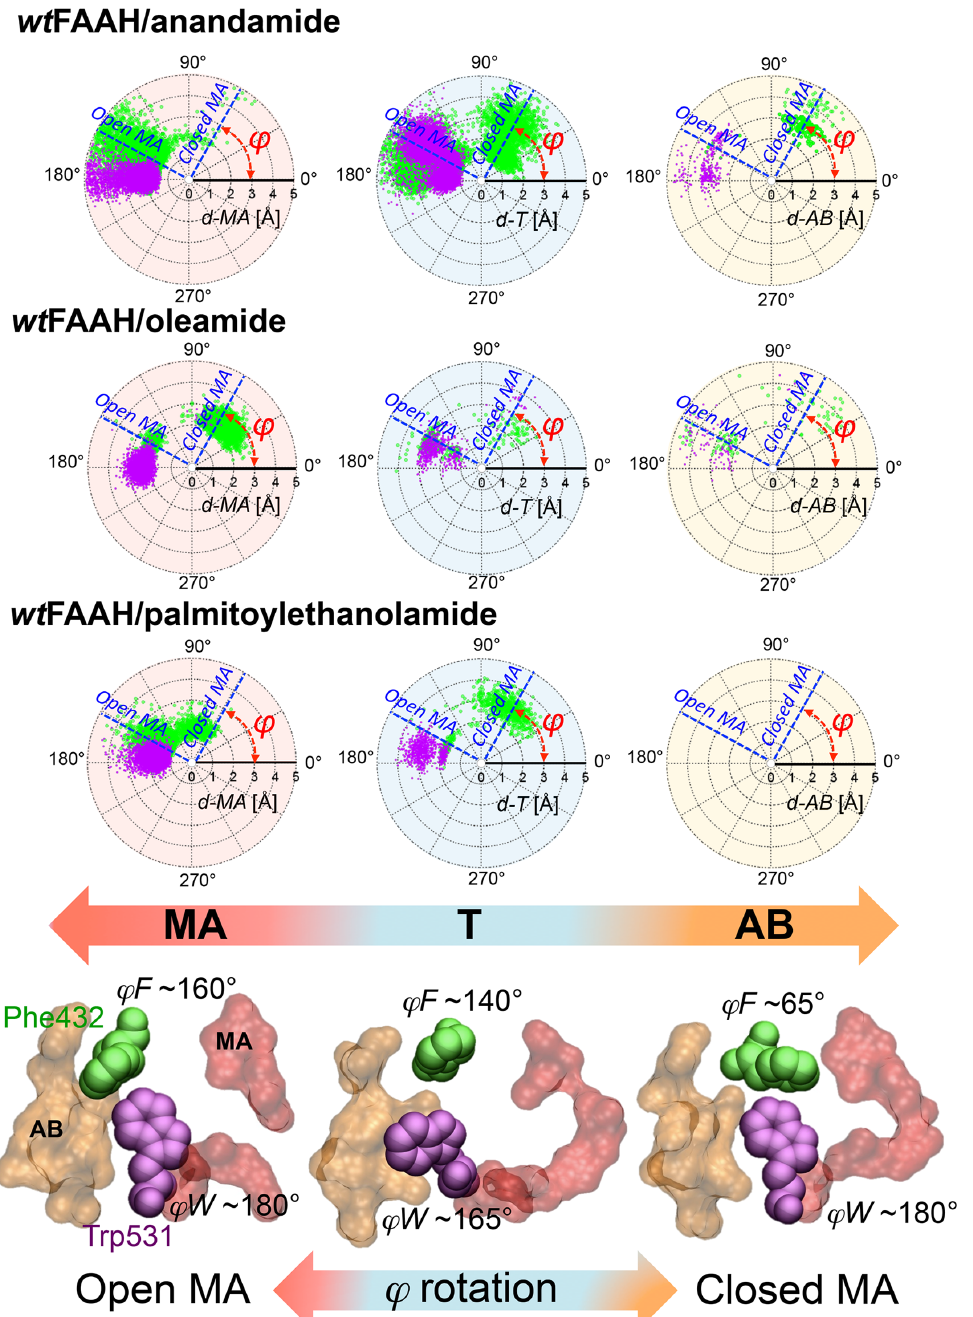
Fig 5. Polar plots of the φ angle (dihedral angle along the C α -C β axis) of Phe432 ( φ F — green dots) and Trp531 ( φ W — violet dots) with respect to the d-MA (red background), d-T (cyan background), and d-AB (yellow background) distances for pre-reactive conformations of the wt FAAH/ anandamide (first row), wt FAAH/oleamide (second row), and wt FAAH/palmitoylethanolamide (PEA — third row) systems. The polar ( d-MA , d-T and d-AB ) and angular ( φ — in red on the plot) coordinates are explicitly indicated on the plots. The approximate values of φ F of Phe432 for the “ open ” and “ closed ” MA channel configurations are highlighted with blue dashed bars. Distances and angles are expressed in Å and degrees, respectively. Definitions of the d-MA , d-T and d-AB distances are reported in the Methods section. Selected snapshots from MD simulations indicating the “ open ” (left) and “ closed ” (right) MA channel configurations, as induced by the rotation of the φ angle of Phe432 and the cooperative Trp531, are shown at the bottom of the polar plots. The MA (red) and AB (orange) channels are represented in molecular surfaces. Phe432 (green) and Trp531 (violet) are shown in space-filling representation. The φ angle of the two residues is explicitly